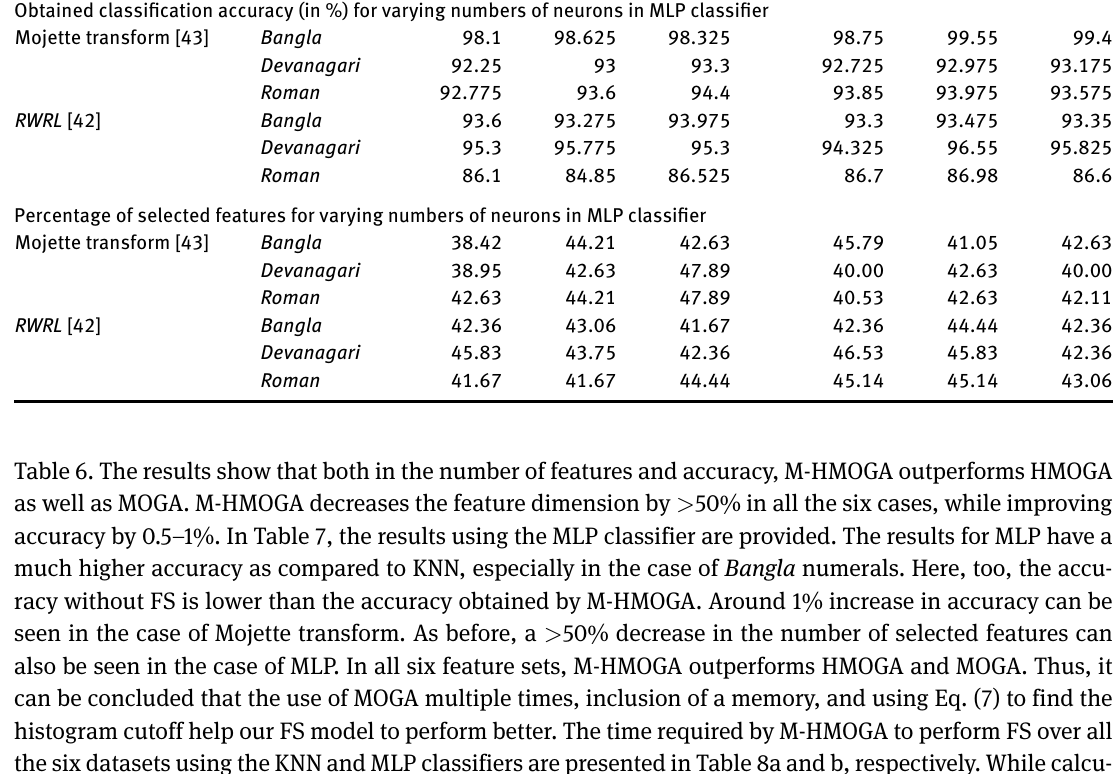
of iterations (20), and the optimal classifier parameter values for different datasets [listed in Table 8a and b]. From the time requirements, it can be easily seen that using MLP as a classifier is a lot more time consuming than using